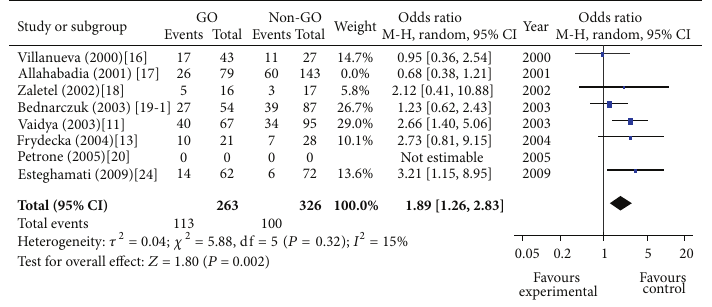
Figure 2: Meta-analysis for the effect of the GG versus the AA genotype on the risk of GO in GD patients in European subgroup. Each comparison is presented by the name of the first author and the year of publication. The point estimate of the odds ratio and the accompanying 95% confidence interval (CI) are shown. “Total” represents the summary random effects estimation for the comparison along with the respective 95% confidence interval. Values above 1 denote an increased risk for GO with the GG genotype.